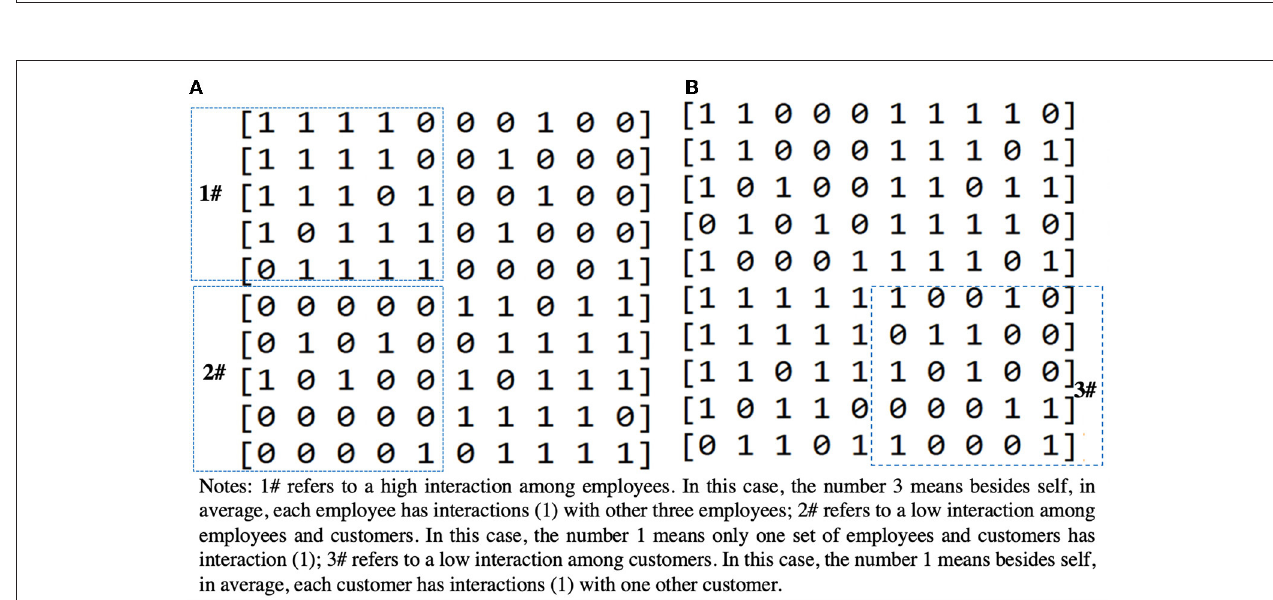
FIGURE 2 | (A) Matrix of NK model, high/high/low = 3/3/1, (B) Matrix of NK model, low/low/high =